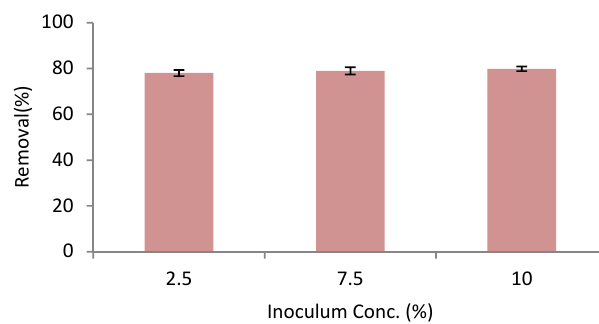
Fig. 3: Effect of inoculum concentration on the removal percentage